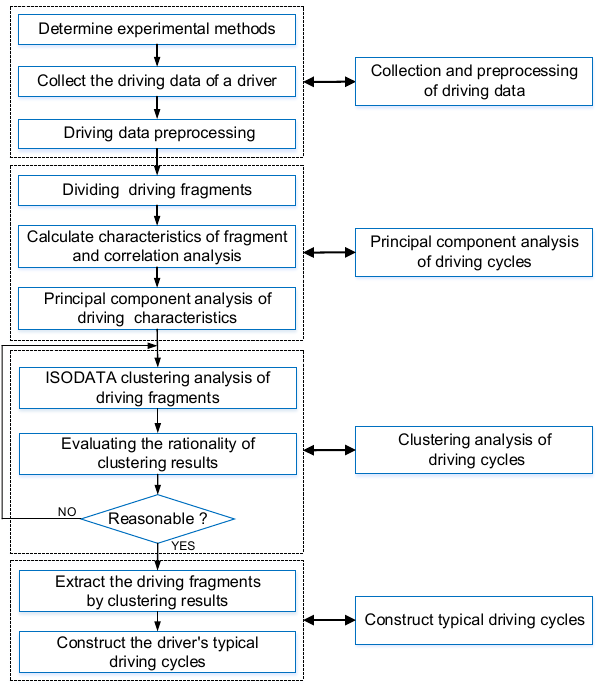
Figure 1. Construction process for typical driving